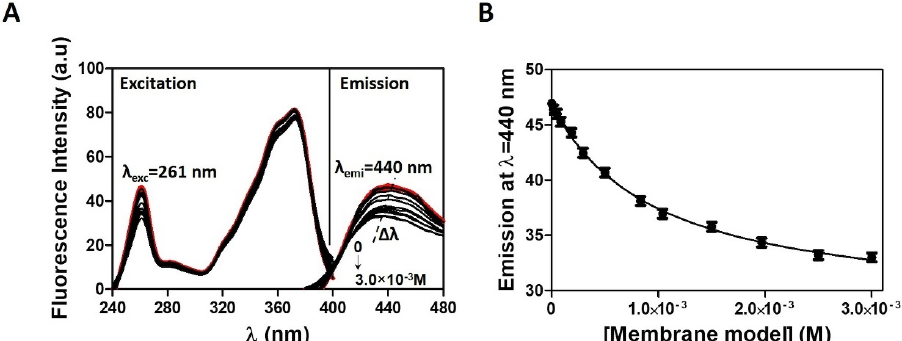
Figure 3. ( A ) Fluorescence emission spectra of CPT (2 × 10 − 5 ) with increasing concentrations of cancer membrane models (0 to 3.0 × 10 − 3 M) in acetate buffer pH = 5.8. In red, are represented